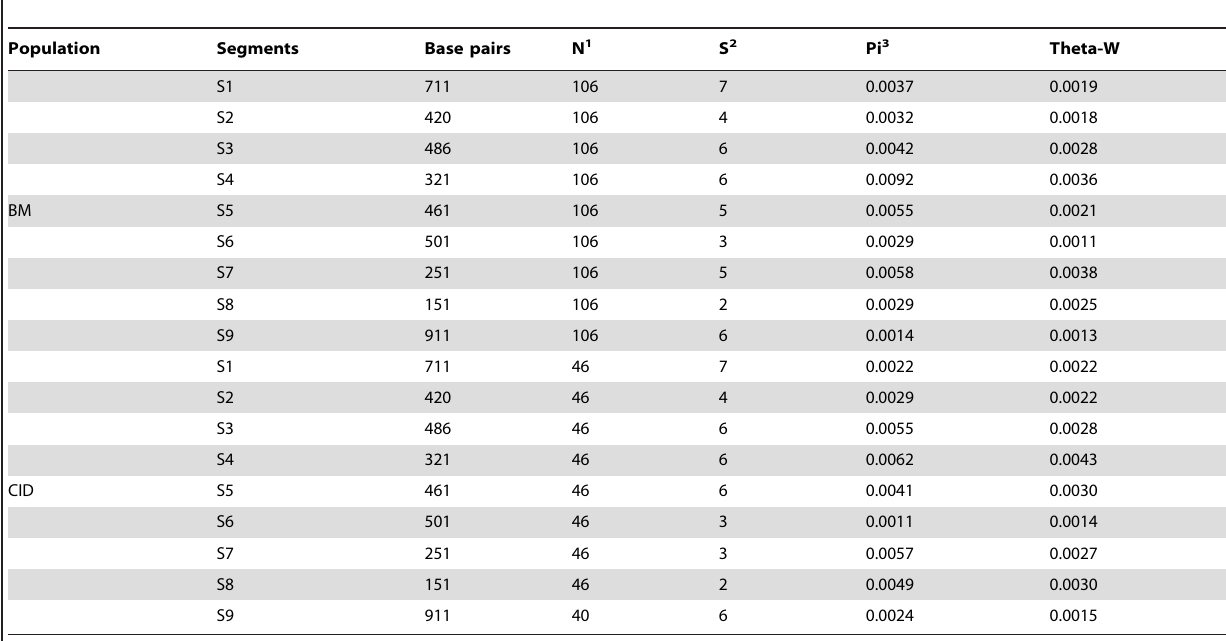
Table 1. Polymorphism statistics and neutral tests in both the BM and CID populations.